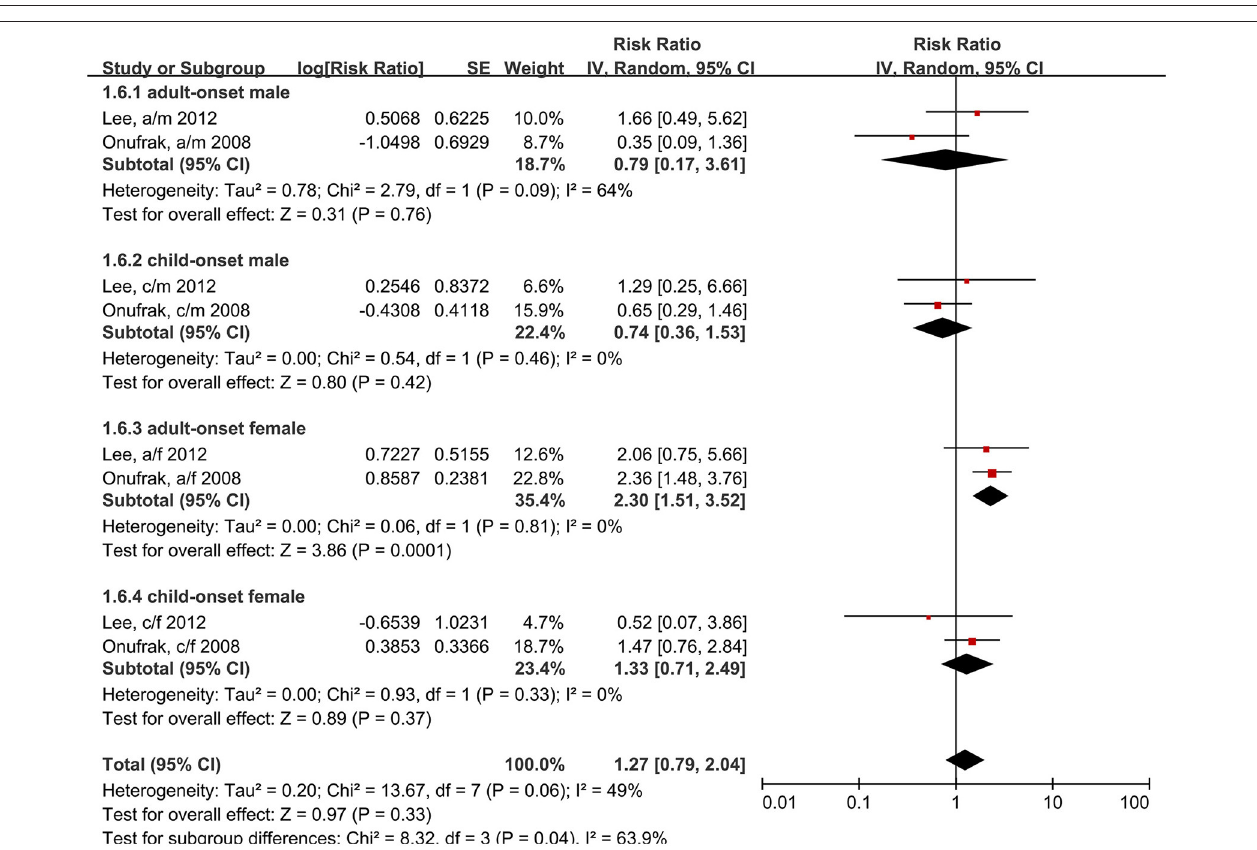
FIGURE 7 | Forest plot shows association between asthma and the risk of stroke in different age of asthma onset and different gender. SE, standard error; IV, Inverse Variance method; df, degrees of freedom; a/f, adult female; a/m, adult male; c/f, child female; c/m, child male.